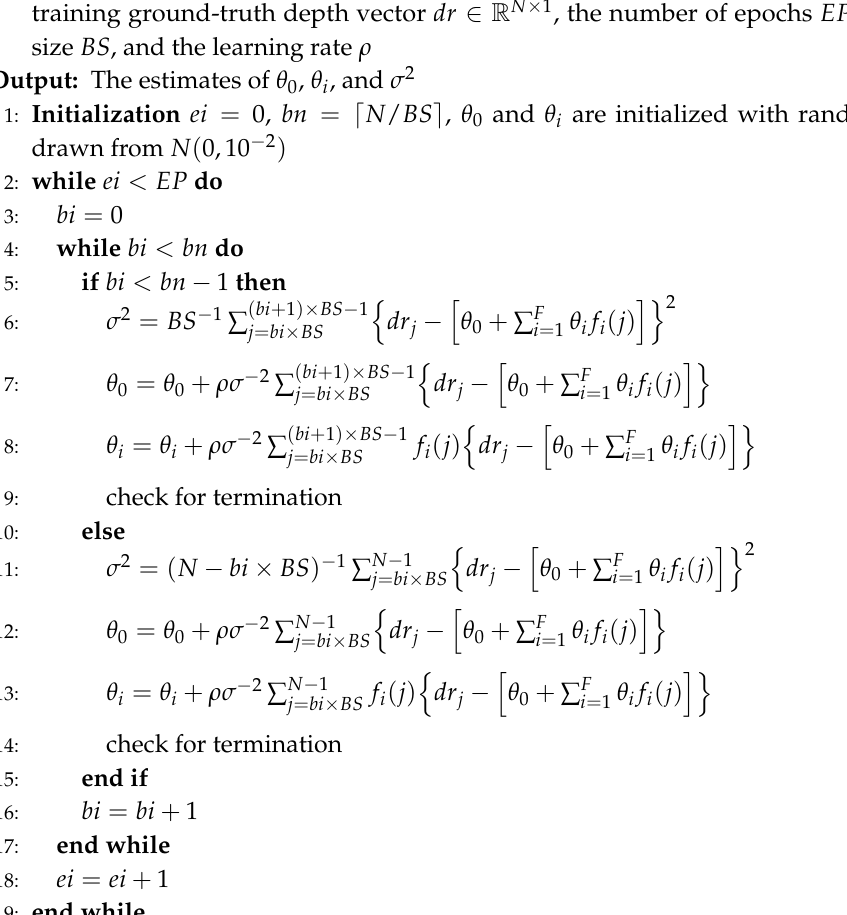
Algorithm 1 Mini-batch gradient